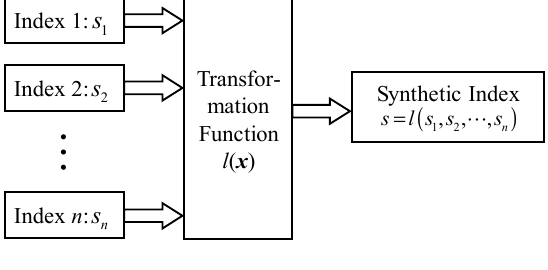
Figure 1. Combination methods.